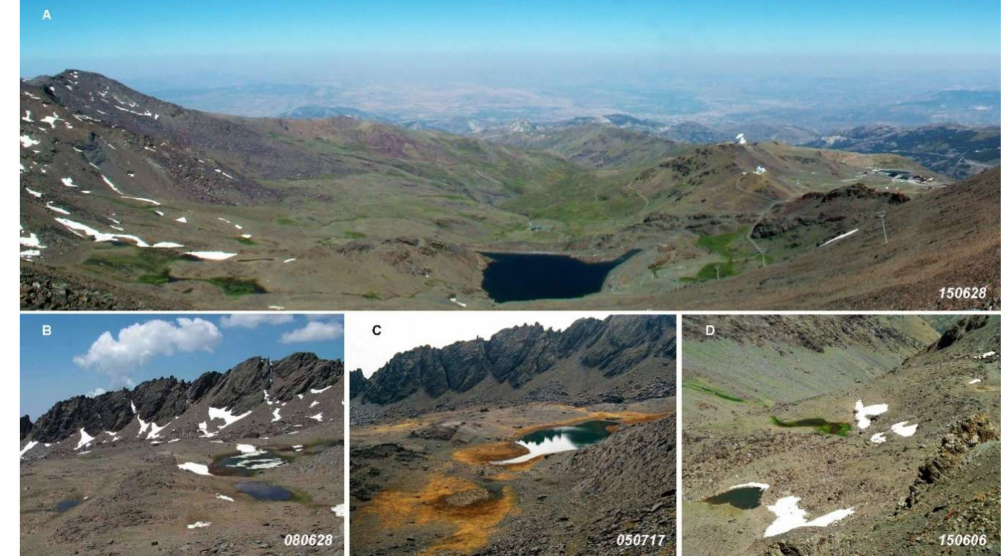
Figure 2. Some observable relations between water-bodies and adjoining watercourses: ( A ) headwaters of the D í lar stream, where Las Yeguas reservoir (centre of image) is supplied by small natural water bodies (Lagunas de la Virgen, left); ( B ) headwaters of the Rioseco stream, where the Rioseco water-body is located, towards the end of thaw and ( C ) in summer of a very dry year; and ( D ) two waterbodies at the headwaters of Valdeinfierno towards the end of thaw, in which the lower is permanent, fed by groundwater from the upper, which is temporary. The numbers in lower right corners indicate the date of each photograph (year, month,